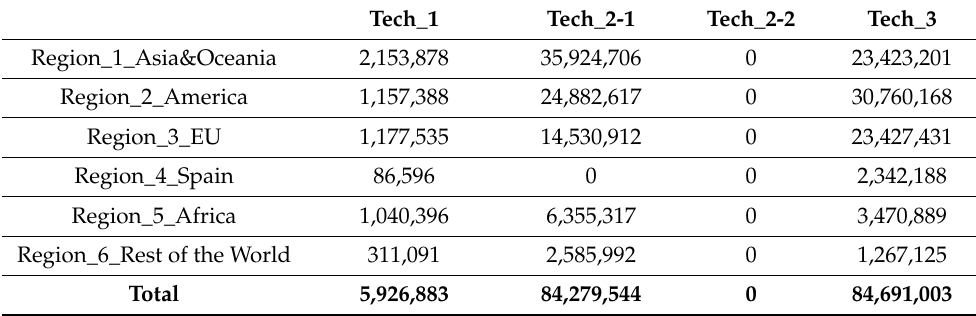
Table 12. Technology-shared factor, ↑ 10% y2. x by region and technology (million